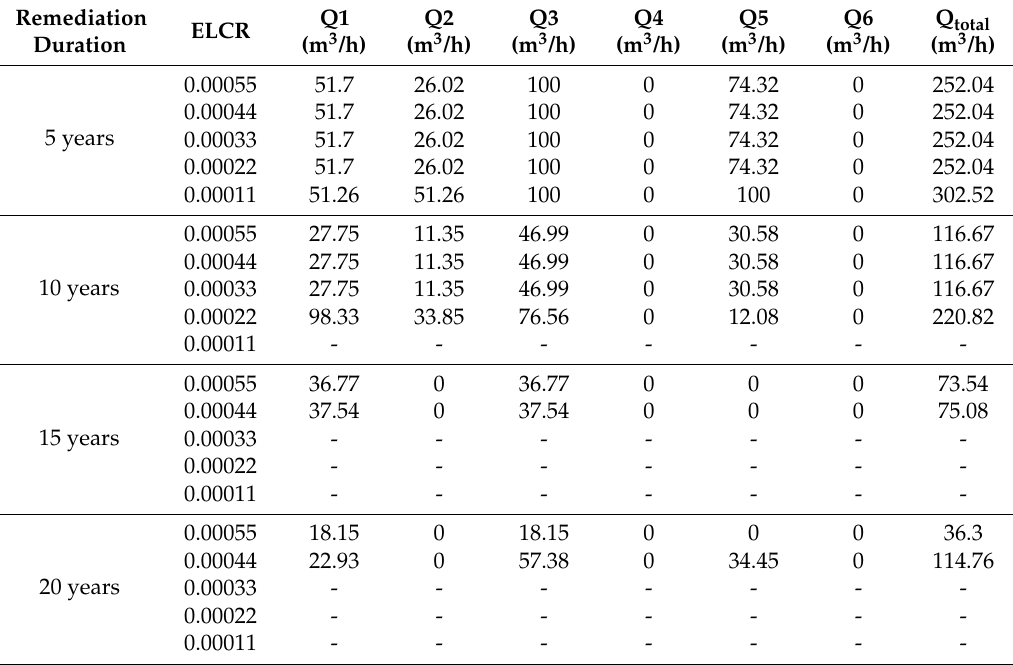
Table 2. The remediation strategies under different scenarios while the environmental standard is 150 µ